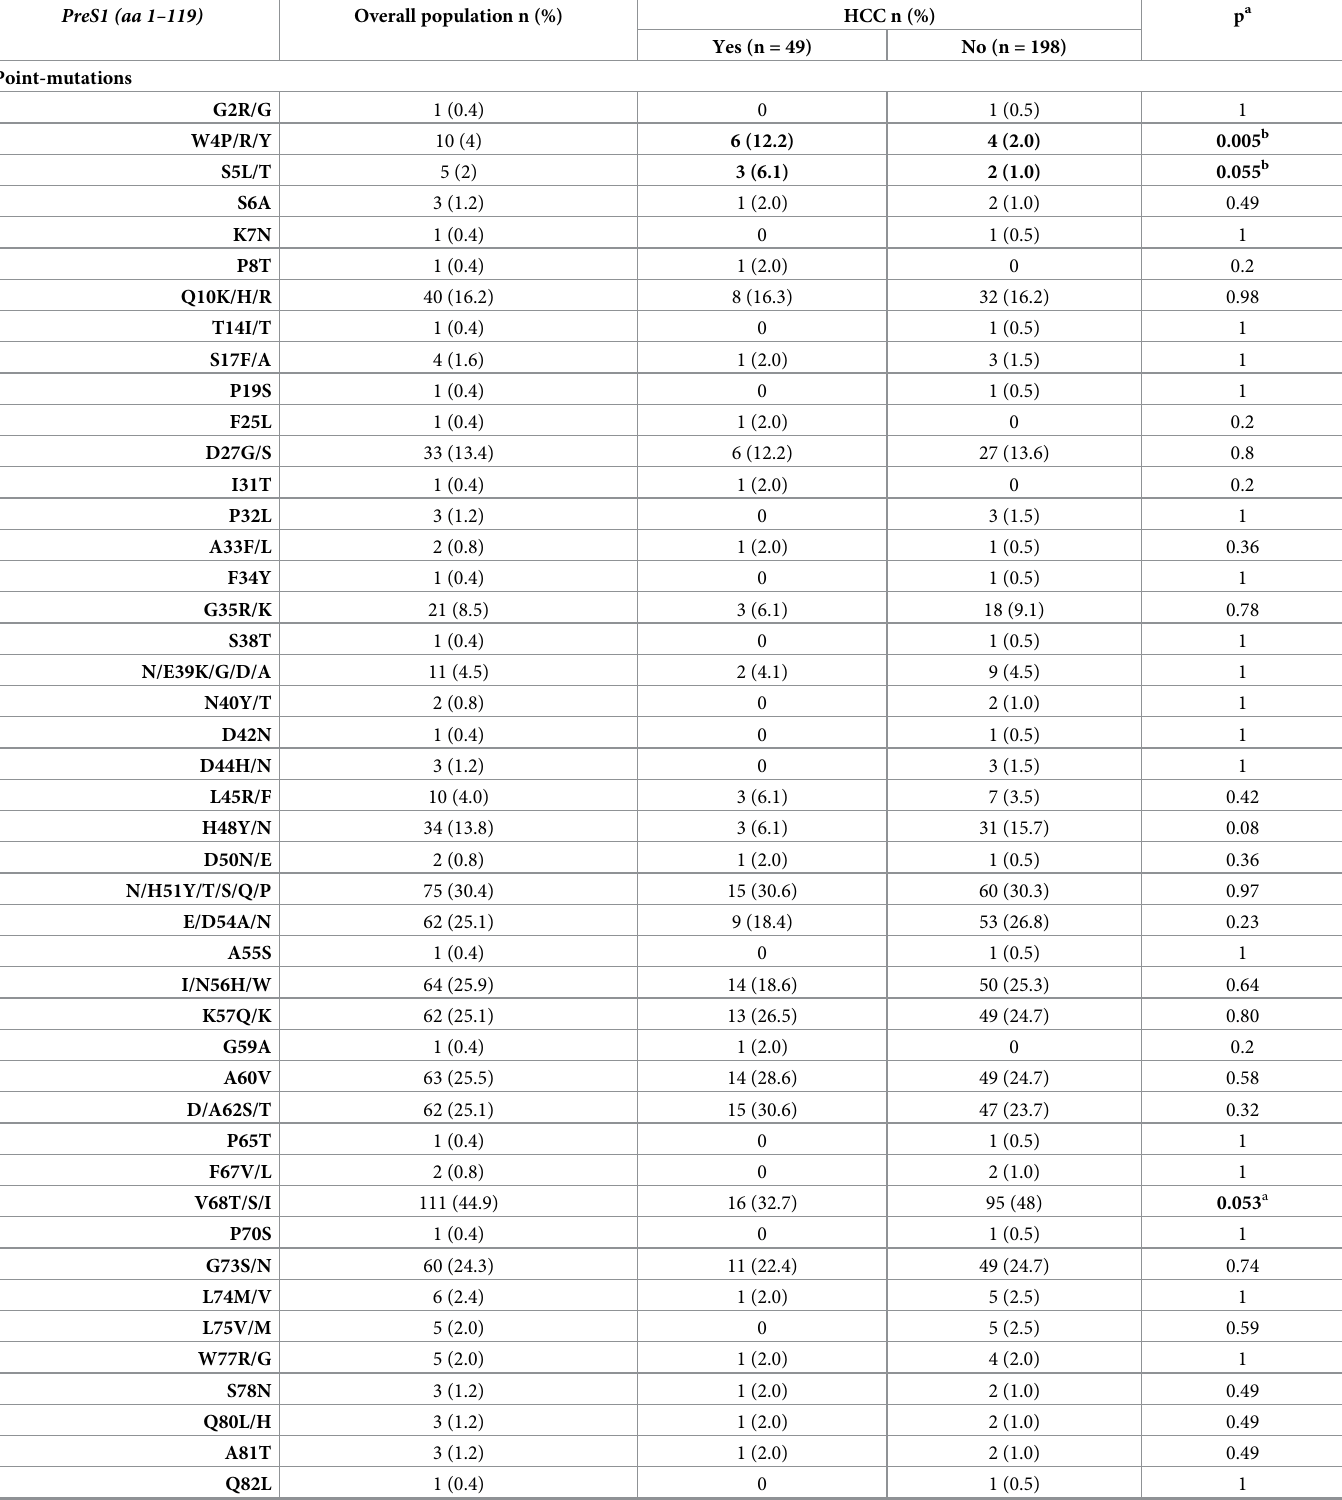
Table 2. Distribution of point and deletion mutations on the PreS1 gene (n = 247). PreS1 (aa 1–119)